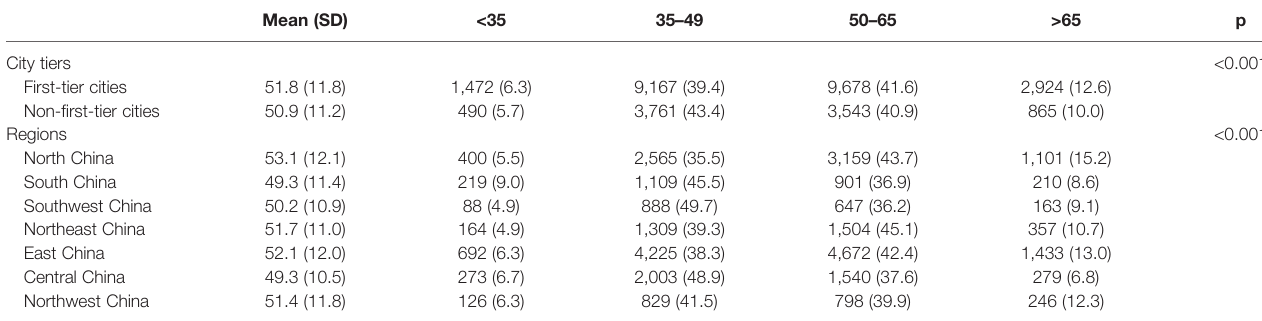
TABLE 2 | Age (years) distribution of city tiers and regions. Mean (SD) <35 35 – 49 50 – 65 >65 p City tiers